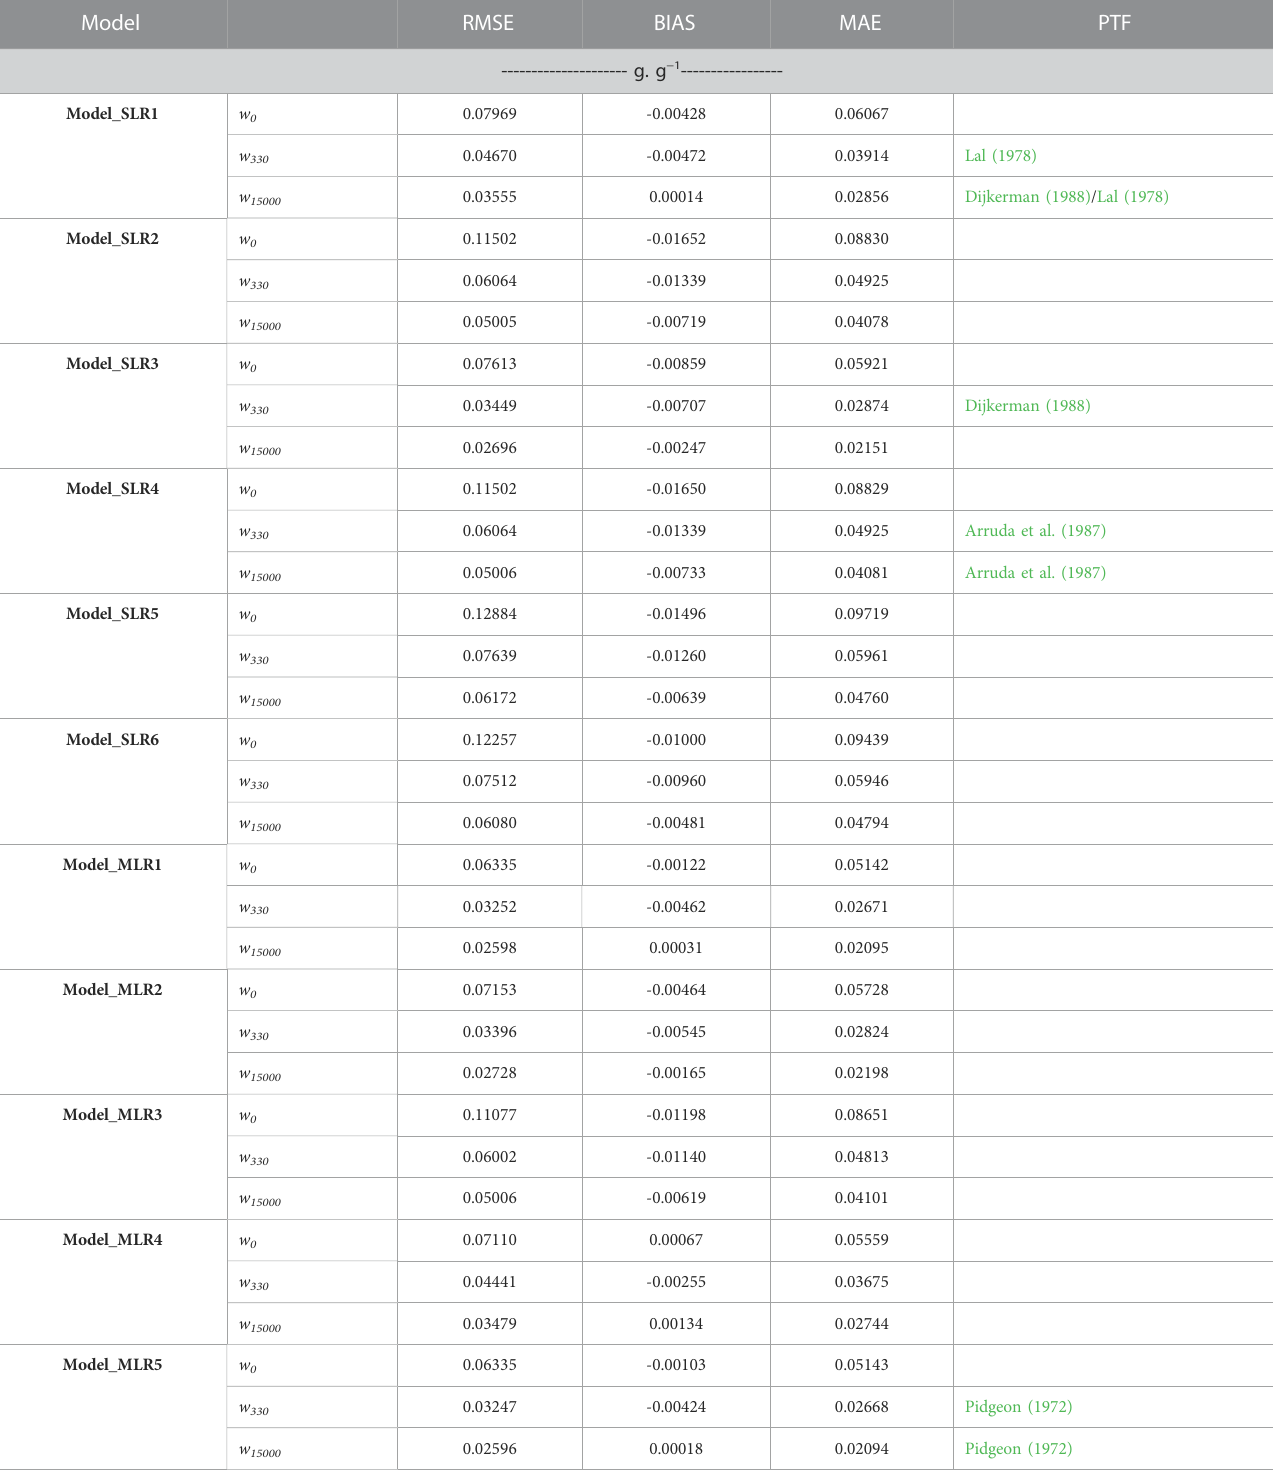
TABLE 7 Evaluation of pedotransfer functions based on simple linear regression (Model_SLR1 to Model_SLR6) and multiple linear regression (Model_MLR1 to Model_ MLR5) using fi eld data in four regions in Morocco, assessed by root mean square error (RMSE), BIAS, mean absolute error (MAE).